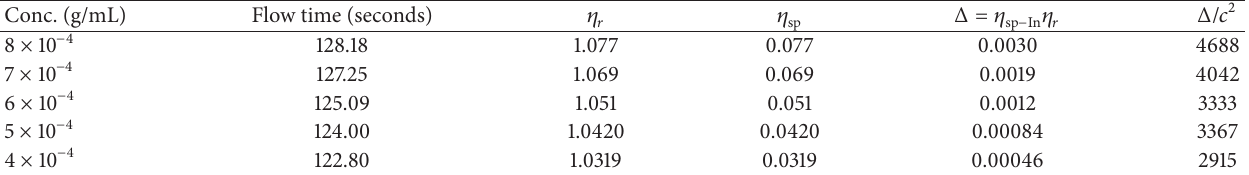
𝜂 Δ / 𝑐 2 on the concentration of sample 6. 𝑟 , and sp − In